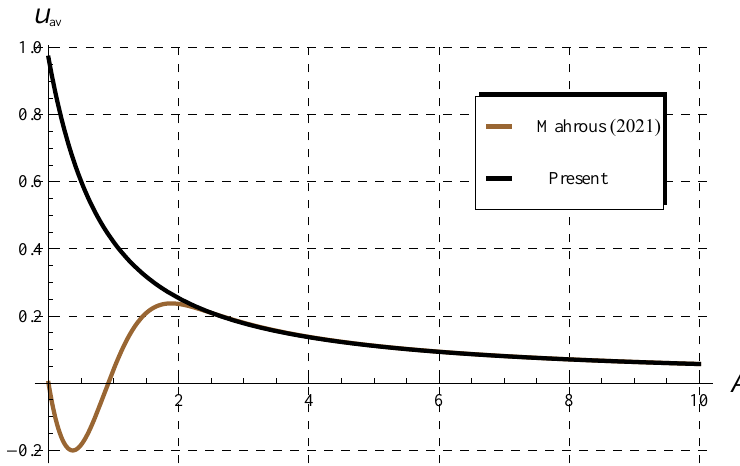
Figure 10. Comparisons between the present cup-mixing average concentration u av and the corre- sponding ones in Mahrous [7] at α = 1 (fractional chlorine decay), A 0 = 1.4, and A 2 = 0.01. 2